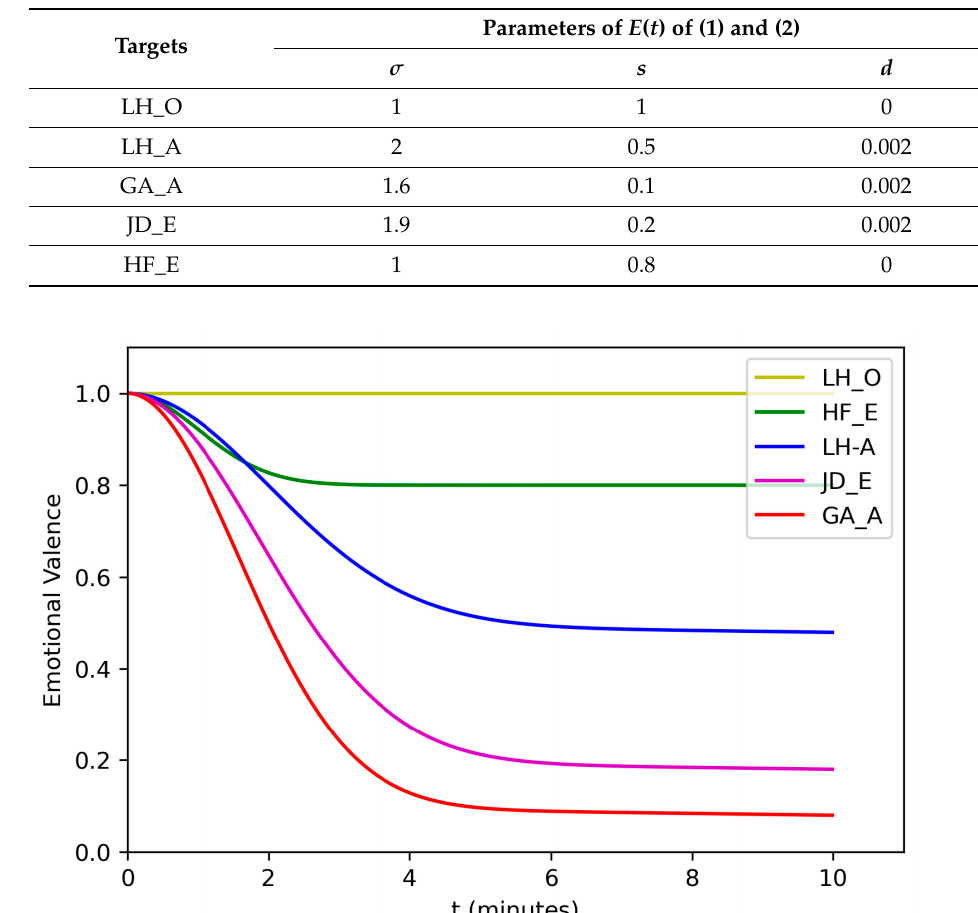
Figure 7. The variation of emotional intensity over time applying the parameters of the targets. In the case of LH_O, the intensity of emotional valance is 1 all of the time, which means a priori valence of the emotion to the fruits. The parameters for the emotion of LH_A has a long duration of the intensity and sustains the emotion with higher intensity than GA_A and JD_E. The intensity of HF_E has a short duration and long sustain with high values because the emotions of hope and fear could maintain high intensity for the future positive or negative events.